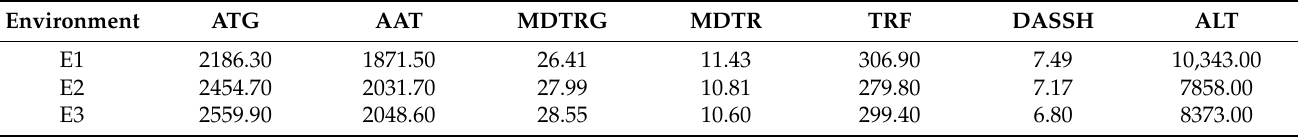
Table 1. The climate data in three plant